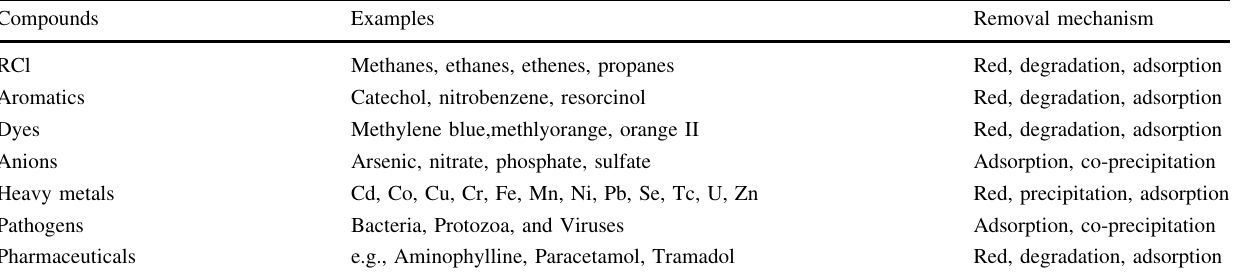
Table 3 Main groups of biological and chemical contaminants that have been successfully treated by Fe 0 /H 2 O systems (batch and